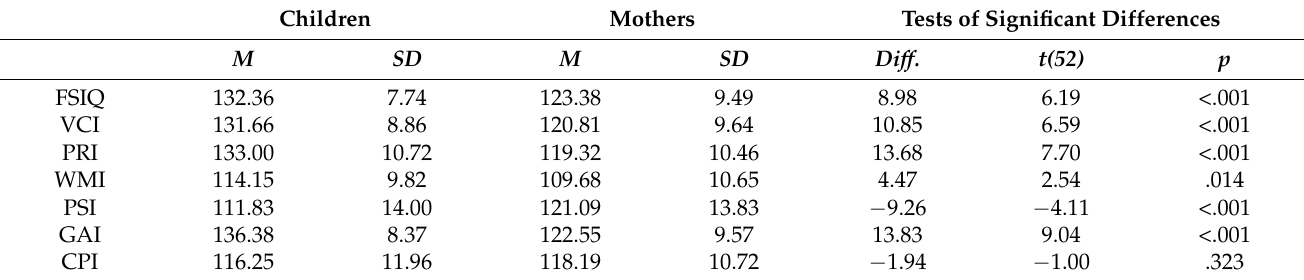
Table 8. Descriptive statistics and tests of significant differences between WAIS-IV and WISC-IV scores in mother-child